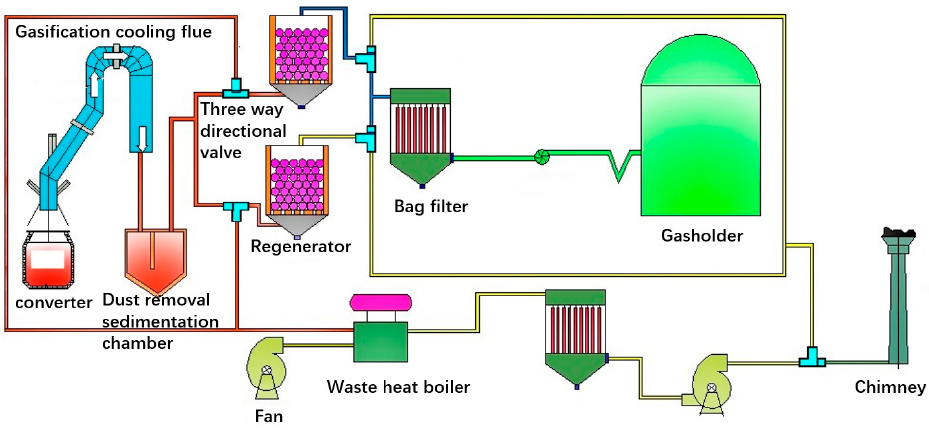
Figure 1. Converter gas purification and waste heat recovery system.